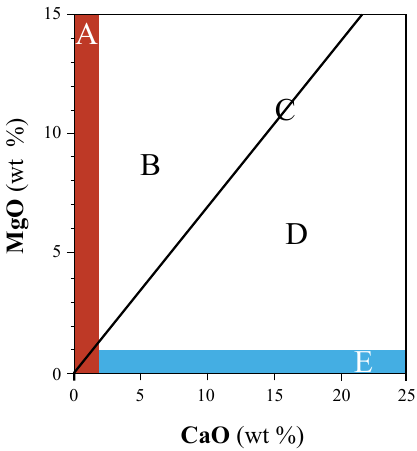
Figure 4. Binary diagram MgO-CaO to ascertain the nature of the Ca-Mg ingredients in the pastes, see explanation in the